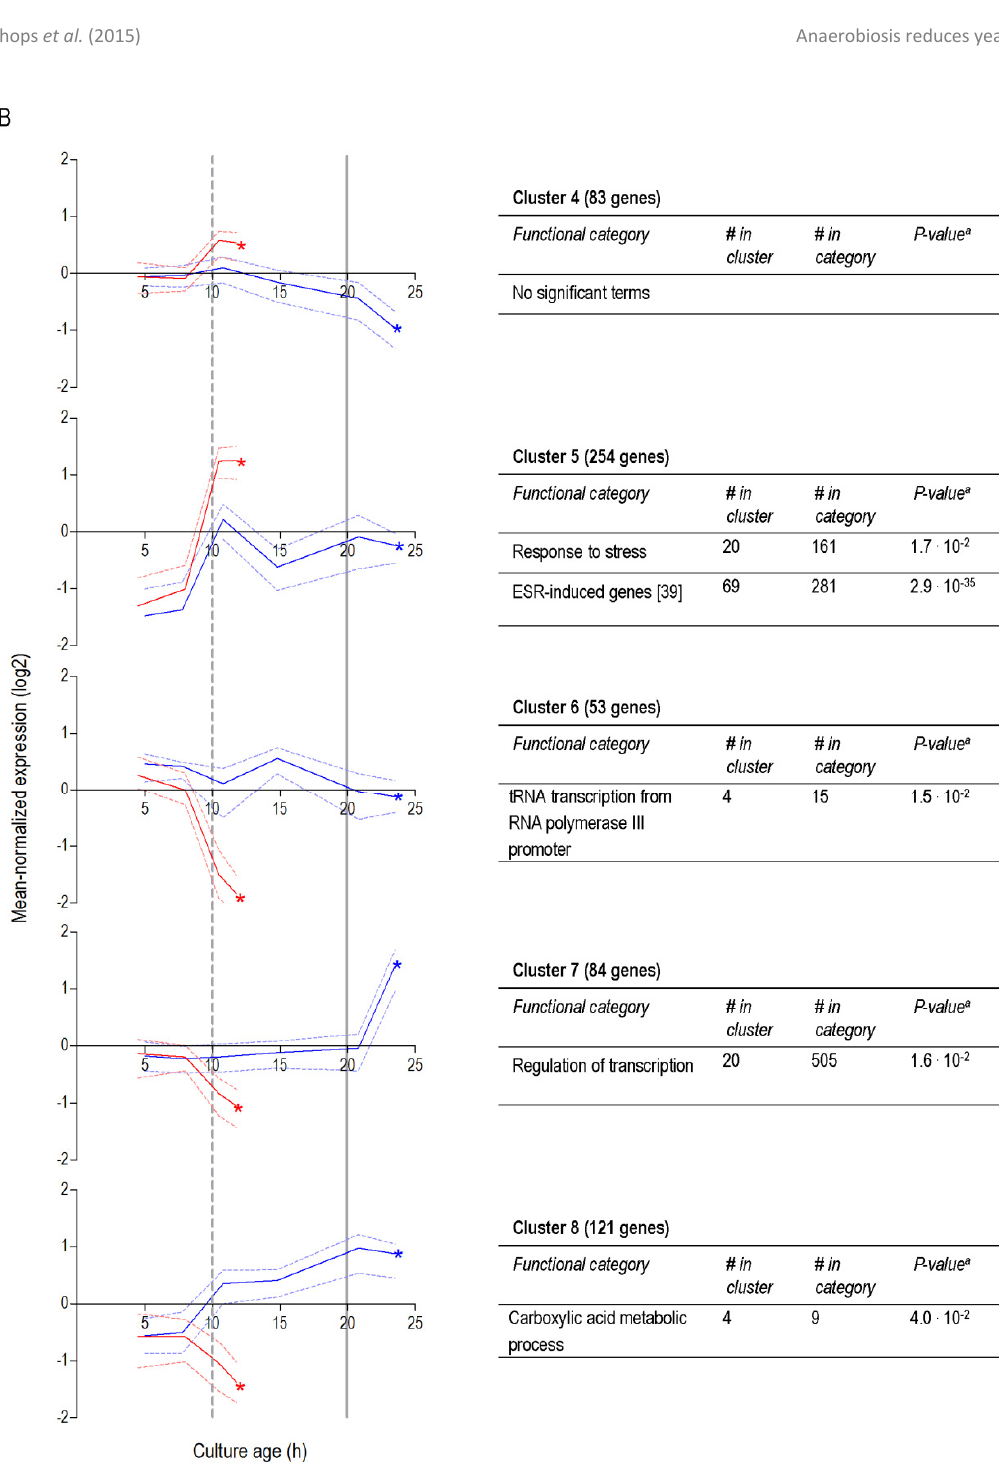
OPEN ACCESS | www.microbialcell.com